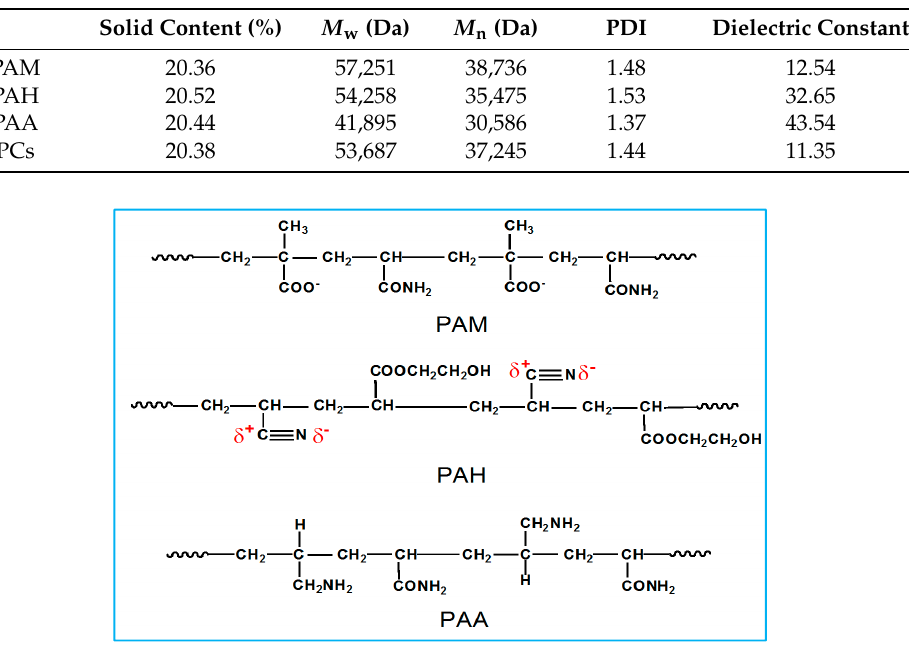
Figure 1. Schematic diagram of the chemical structures of PAM, PAH, and PAA.